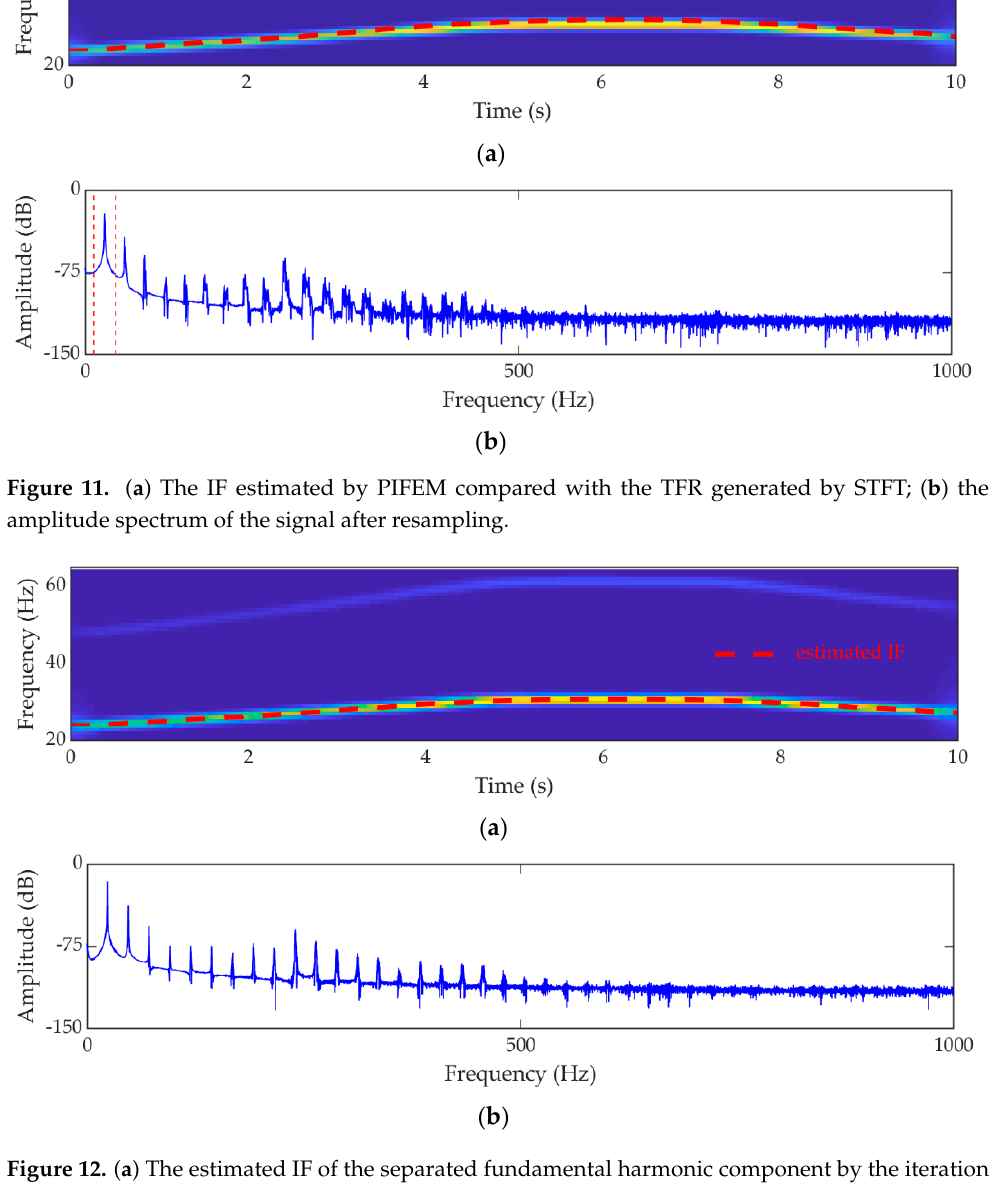
Figure 12. ( a ) The estimated IF of the separated fundamental harmonic component by the iteration procedure compared with the TFR generated by STFT; ( b ) the amplitude spectrum of the signal after resampling.